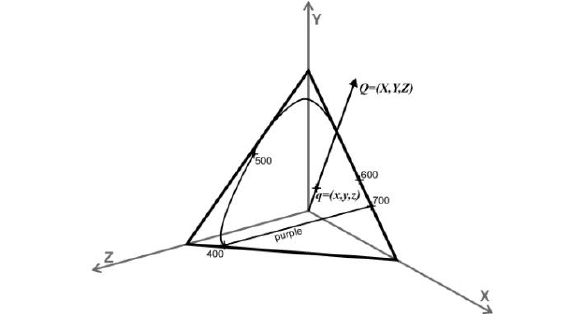
Figure 2. Normalised plane xyz in the tristimulus space.